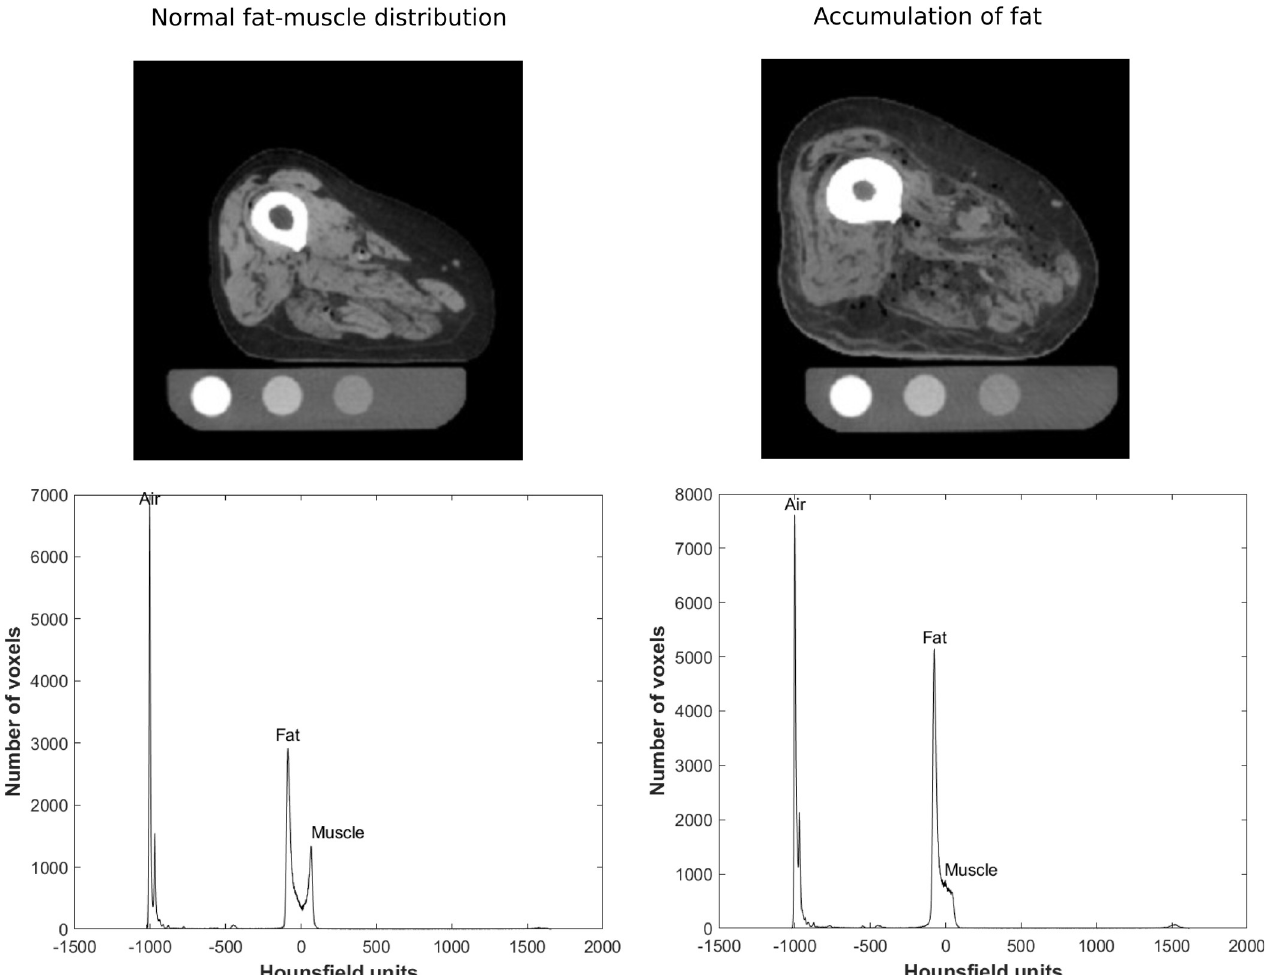
Fig 8. Slices of the same diaphyseal region from the CT scans of femur 4 (left) and femur 5 (right) with the corresponding HU histograms. Femur 5 shows accumulation of fat in the muscle tissue.